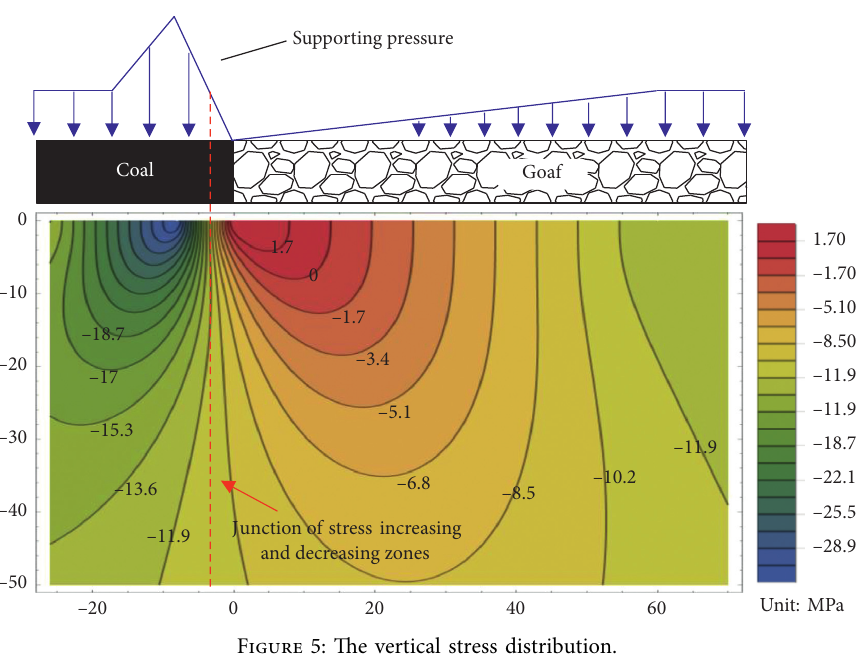
Figure 5: The vertical stress distribution.